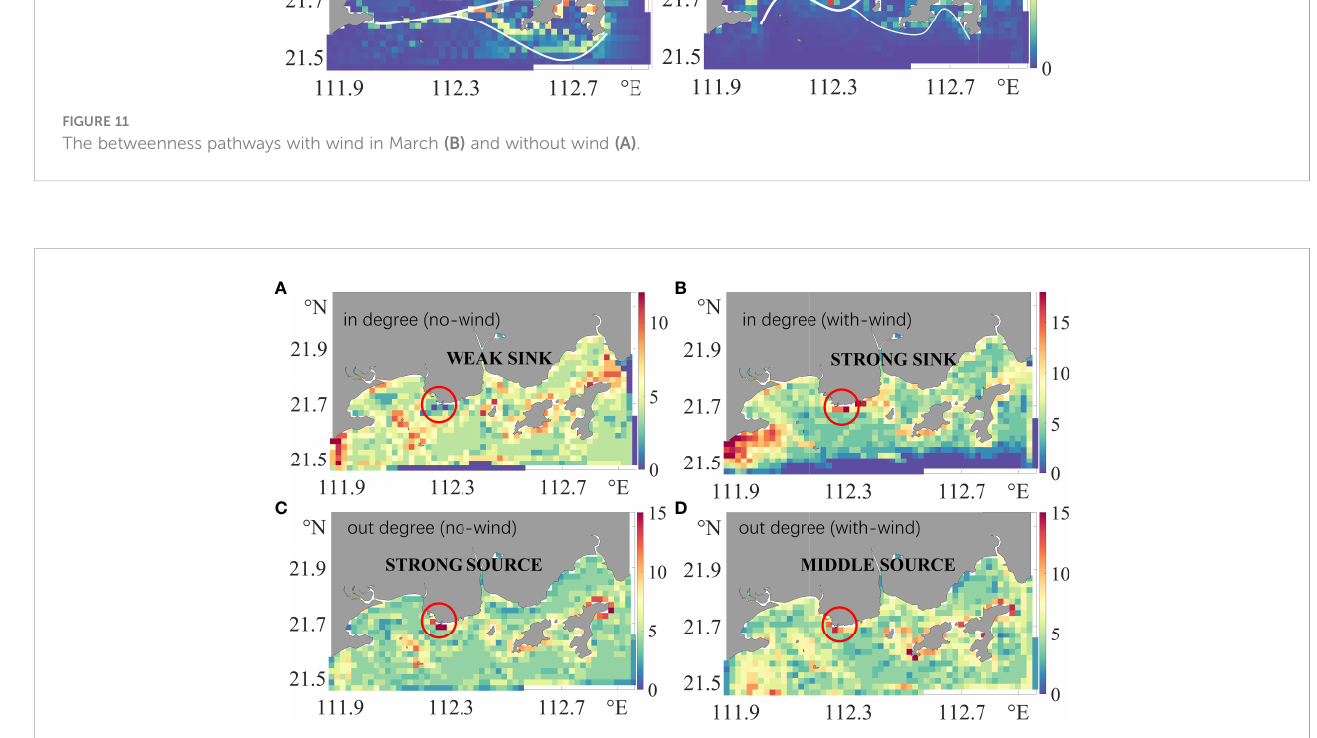
FIGURE 12 In-degree (A, B) and out-degree (C, D) under the no-wind and with-wind